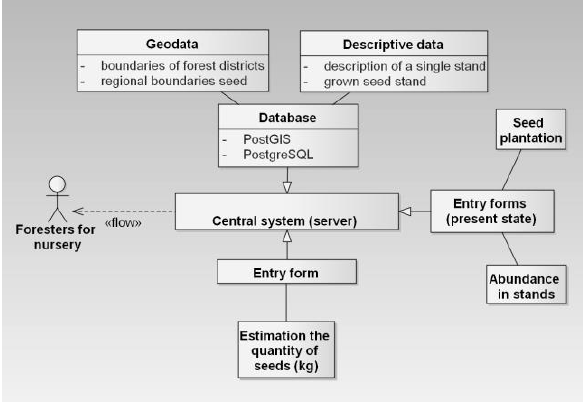
Figure 1. Basic WebGIS based portal